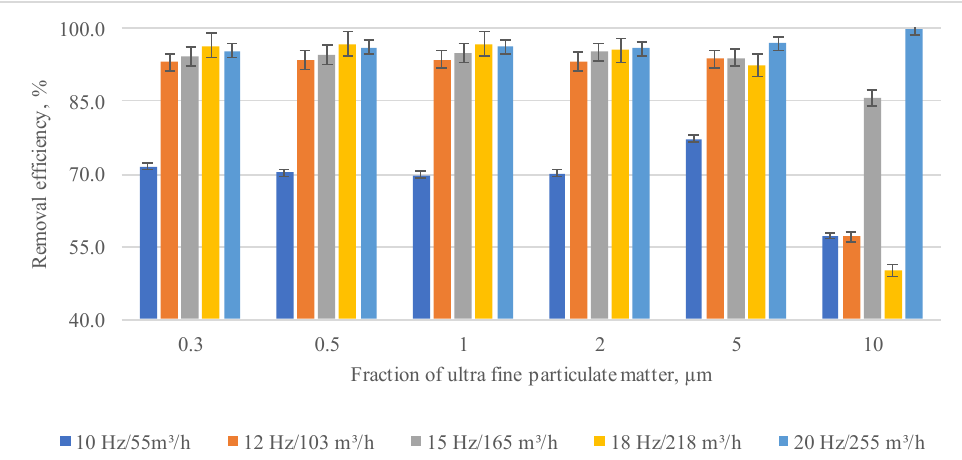
Figure 4. Dependence of the removal efficiency of the apparatus on the fraction of ultra-fine particulate matter in different cases of fan rate and air flow rate.